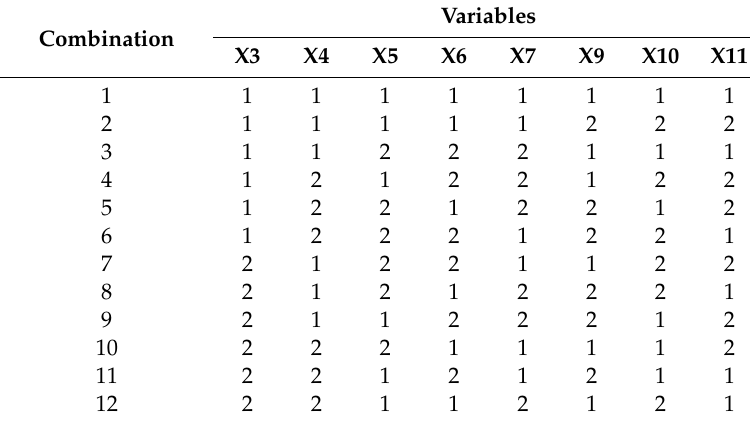
Table 11. L 12 (2 8 ) OA of ACLR conditions.